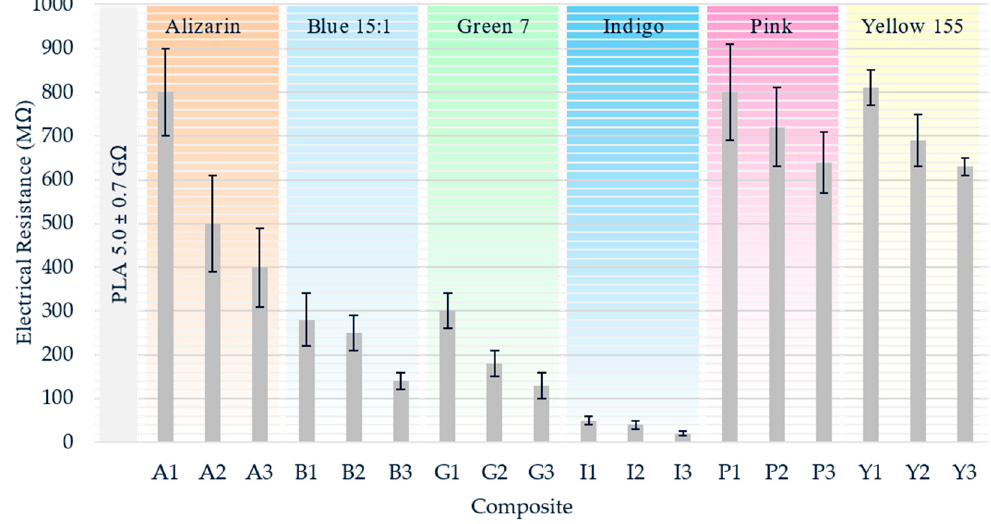
Figure 13. Electrical resistance of PLA and its composites containing 1%, 2% and 3% (w / w) of each additive.